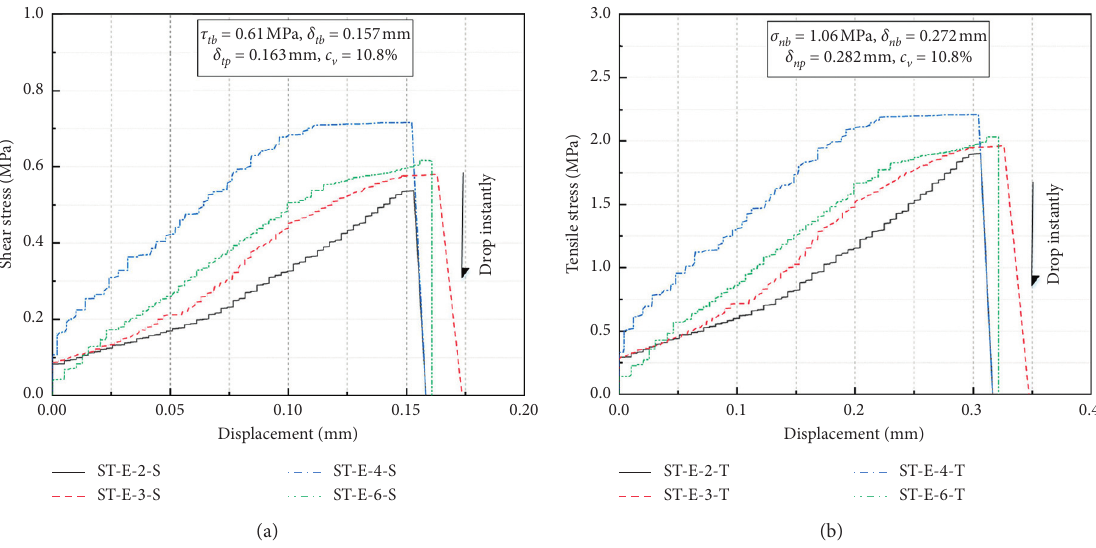
Figure 7: Stress-displacement curves of the interface normal and tangential direction of various specimens in the tensile-shear test. (a) The shear stress-displacement curve of specimen ST-E. (b) The tensile stress-displacement curve of specimen